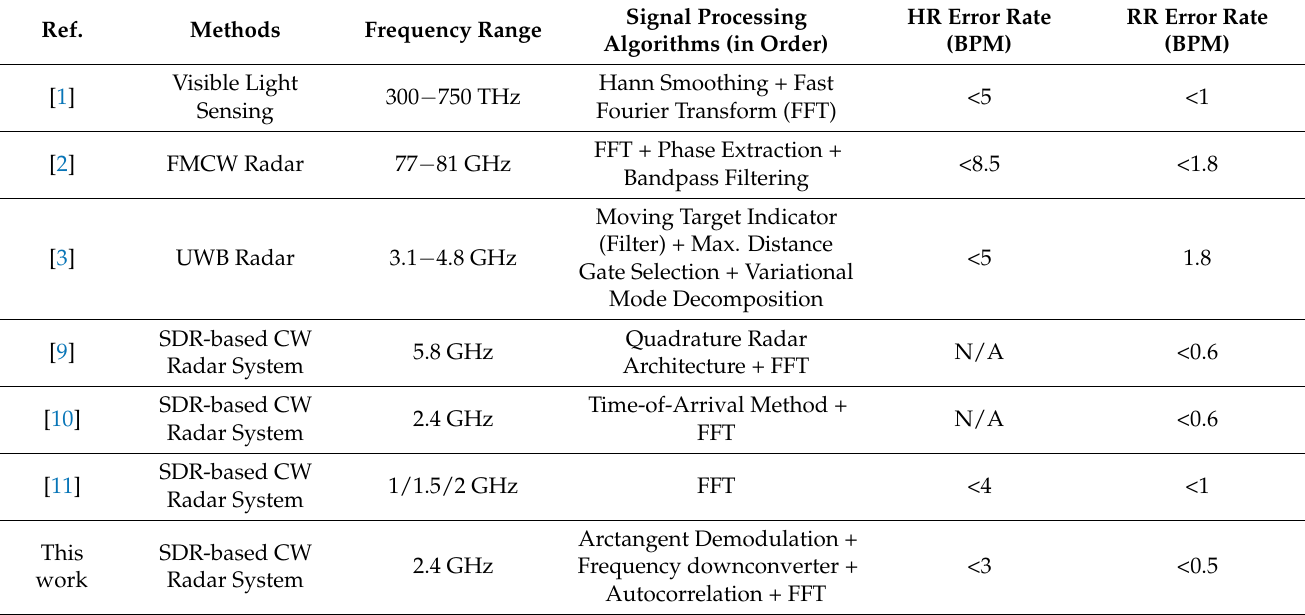
Table 1. HR and RR error rates comparison among different NCVS sensing methods.